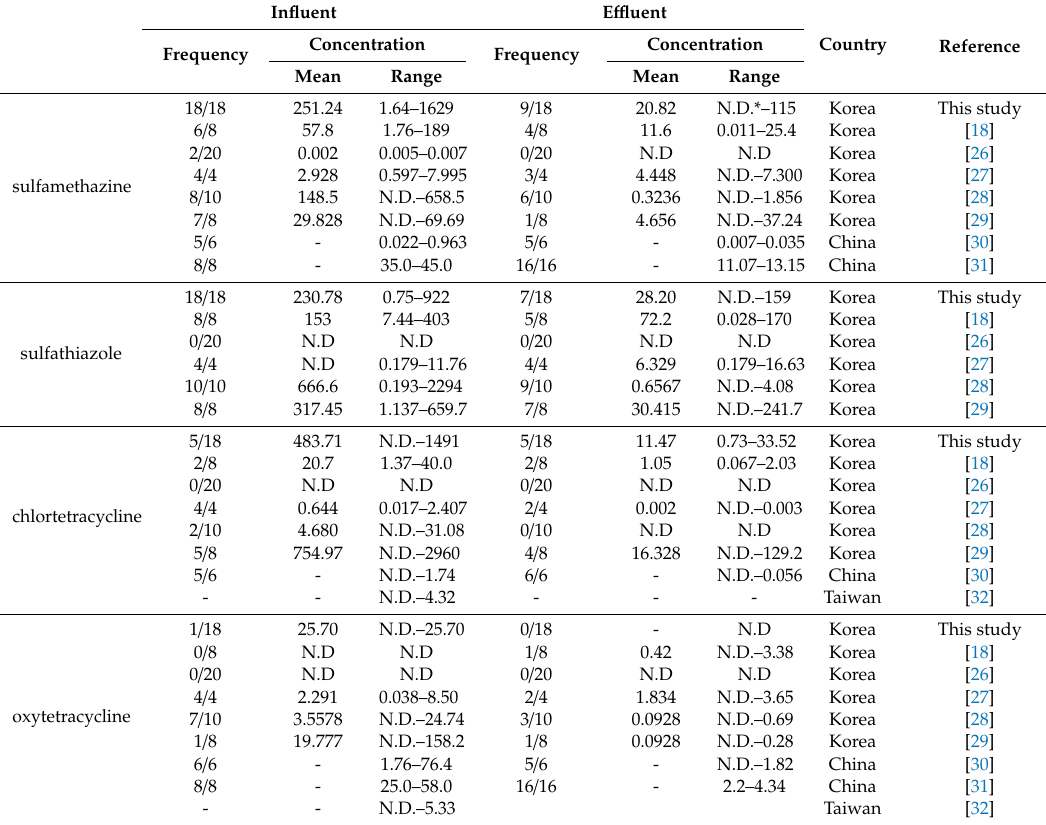
Table 7. Influent and e ffl uent concentrations in livestock wastewater treatment plants at home and abroad (unit: µ g /